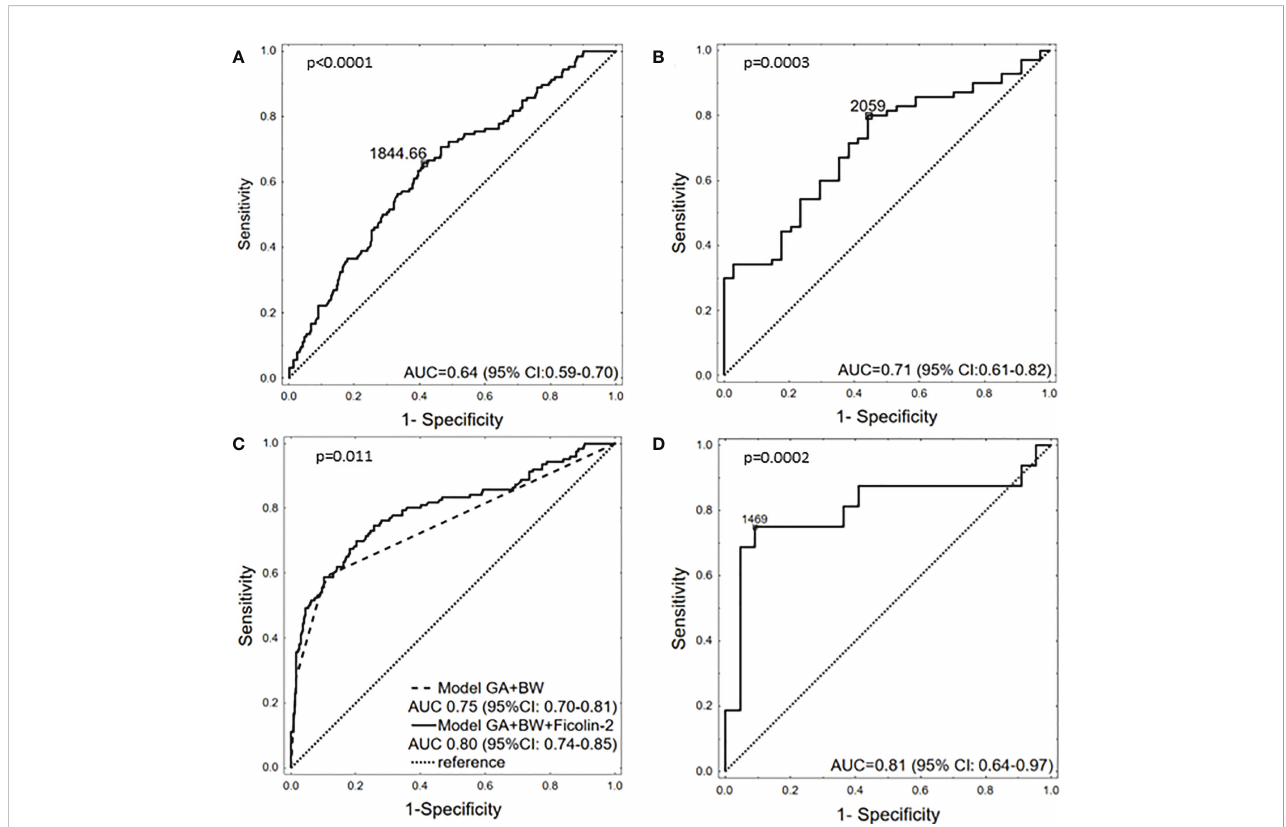
FIGURE 3 The potency of fi colin-2 to differentiate between babies with and without RDS in whole cohort (A) , between neonates with and without RDS, born at GA <33 (B) , between neonates with and without RDS, depending on GA (<33 vs. ≥ 33) and BW (<1500g vs. ≥ 1500g) (C) and between babies born at GA <33 with mild (I) and moderate/severe (II+III) RDS (D)